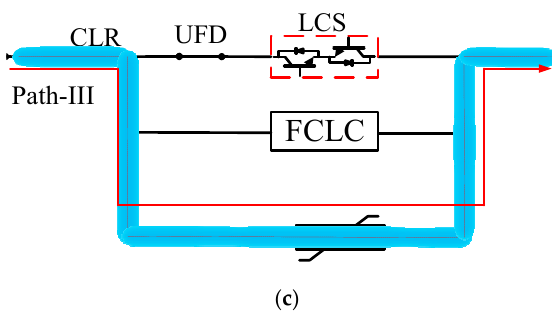
Figure 5 . Flow of current through different branches of breakers during different time intervals: ( a ) 0 ≤ t ≤ t 1 and t 1 ≤ t ≤ t 2 ; ( b ) t 2 ≤ t ≤ t 3 ; ( c ) t > t 3 .